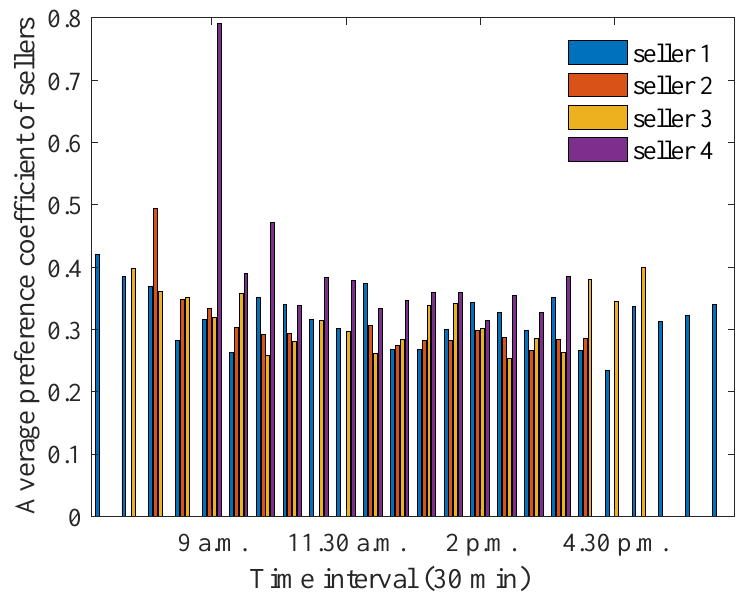
Figure 11. Optimum preference coefficients for sellers during summer months.